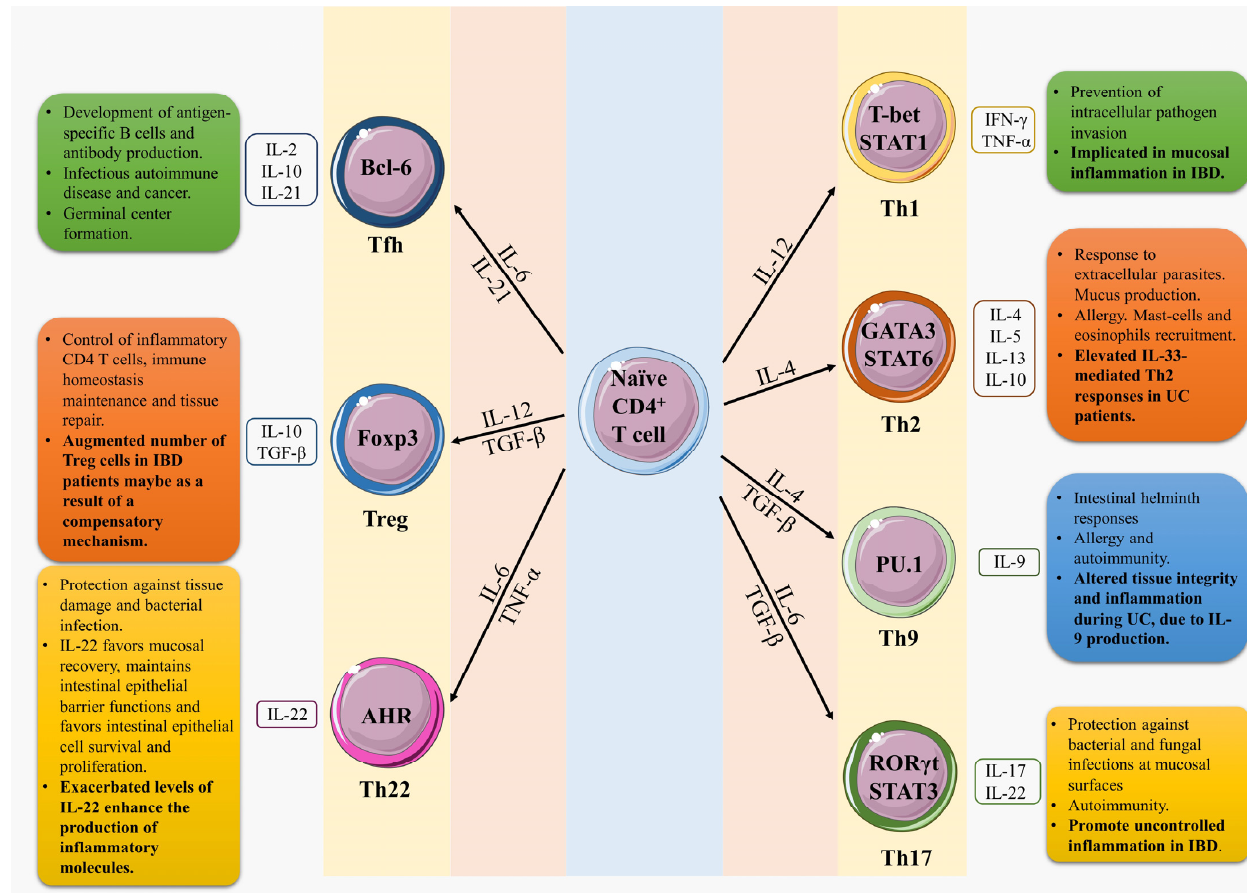
Figure 1. T-cell differentiation, subsets, and main functions. Naive CD4 T-cells can undergo differ- entiation into distinct effector subsets (e.g., Th1, Th2, Th9, Th17, and Th22 cells), follicular helper T (Tfh) cells, and regulatory phenotypes (Treg), each producing a characteristic set of cytokines (unfilled boxes next to cells). This differentiation process is mediated in part by the local cytokine microenvironment (arrows), which activates specific transcription factors and signaling molecules (text inside cells). Color-filled boxes next to cells list functions in homeostasis and in IBD (bold text). IBD is associated with changes in T-cell populations.